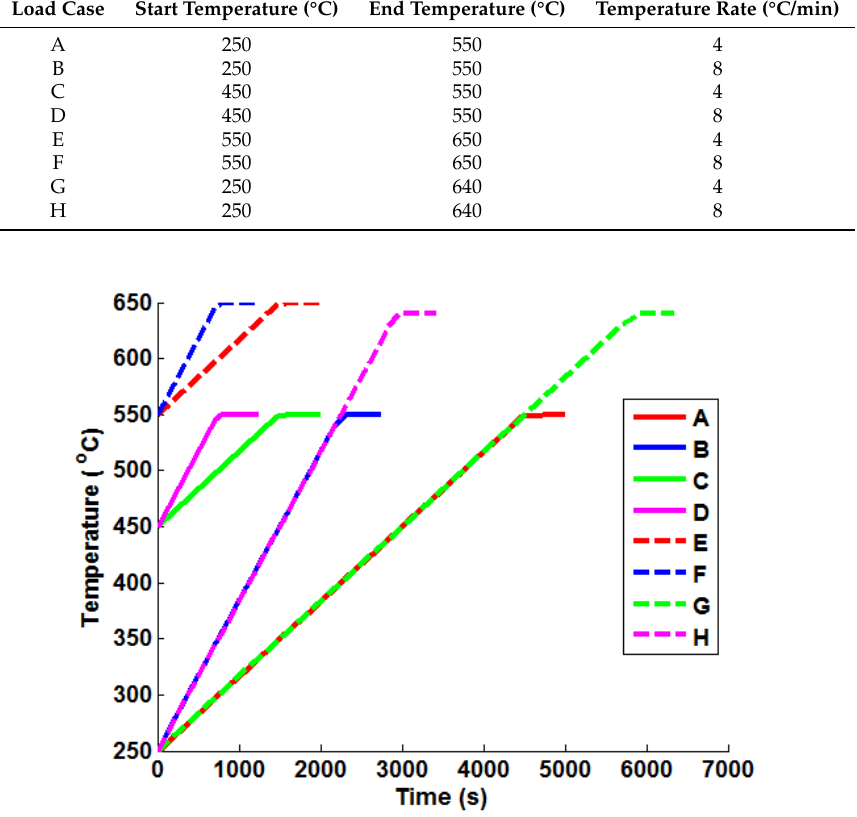
Figure 3. Plots of the representative ramp up temperature profiles used to test the various Green’s function implementation